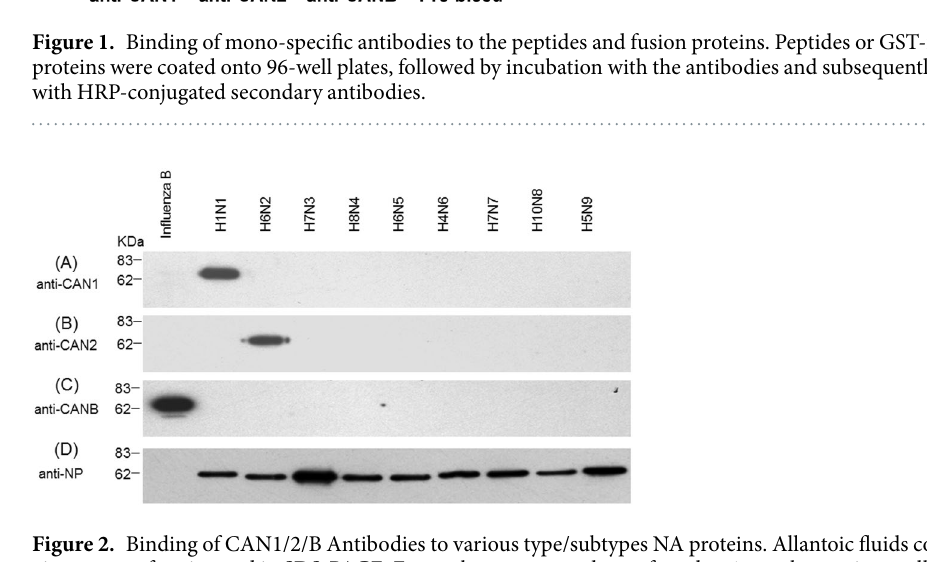
Figure 2. Binding of CAN1/2/B Antibodies to various type/subtypes NA proteins. Allantoic fluids containing viruses were fractionated in SDS-PAGE. Four gels were run and transferred to 4 membranes in parallel, followed by detection of the NA proteins using the CAN1 antibodies (panel A), CAN2 antibodies (panel B), CANB antibodies (panel C). Rabbit polyclonal anti-NP (nucleoprotein) proteins of influenza A viruses were used as control (panel D). Note: Anti-NP antibody against type A cannot bind to the NP of type B viruses. Original pictures see Supplementary Figure